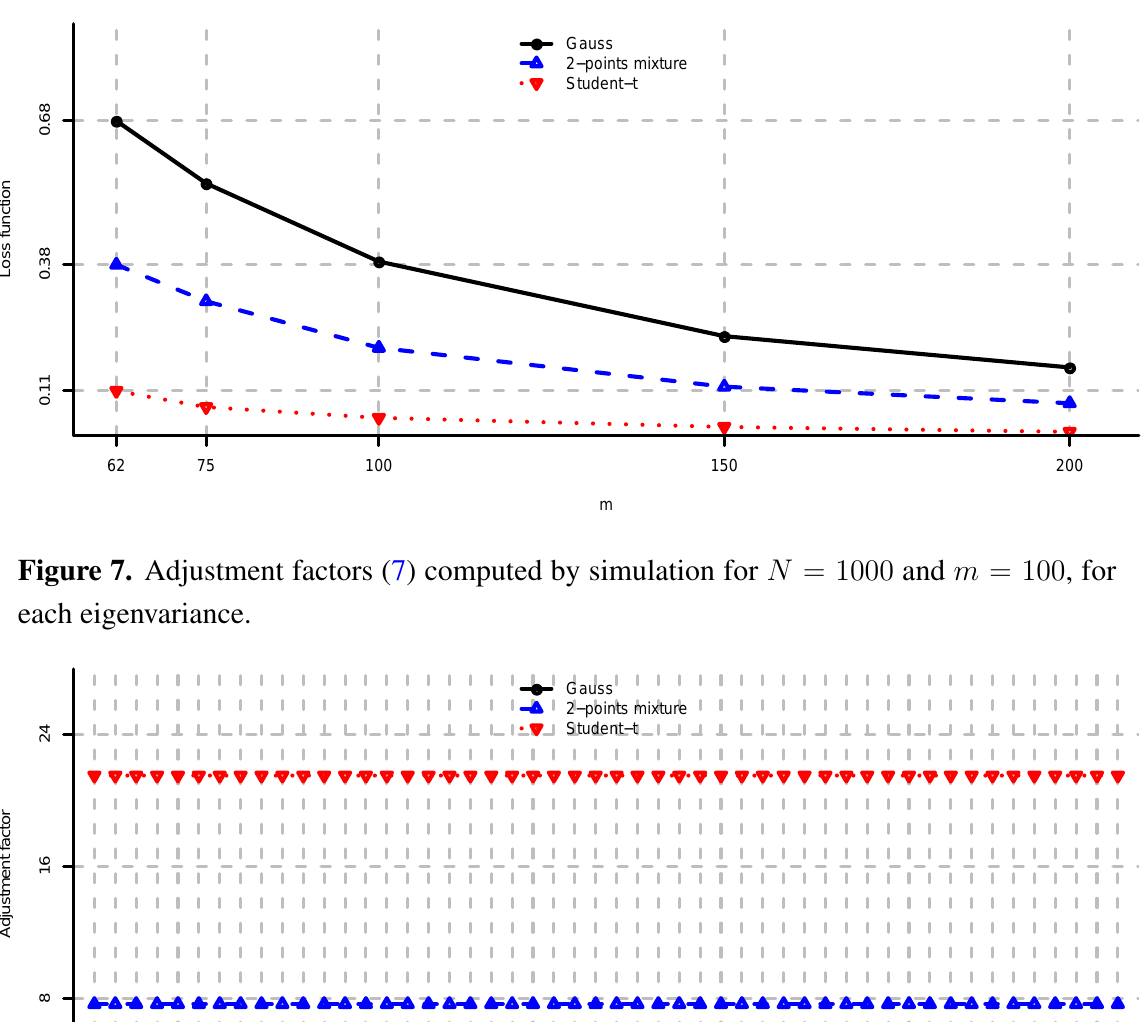
, . . . , c are selected according to Equation (11). 1 n